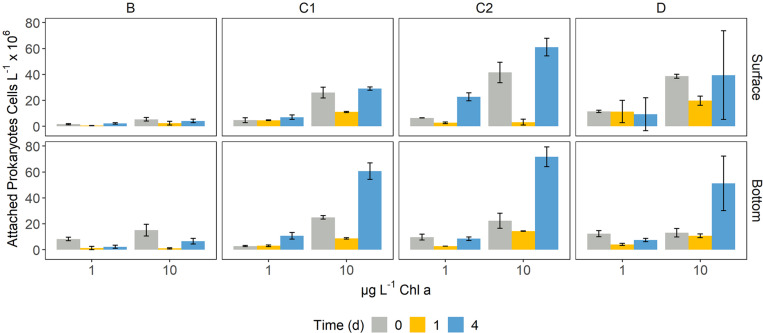
Bar plots showing the abundance of attached prokaryotes on d0, d1, and d4 in each of the microcosms. Error bars represent the standard deviation of two experimental replicates.